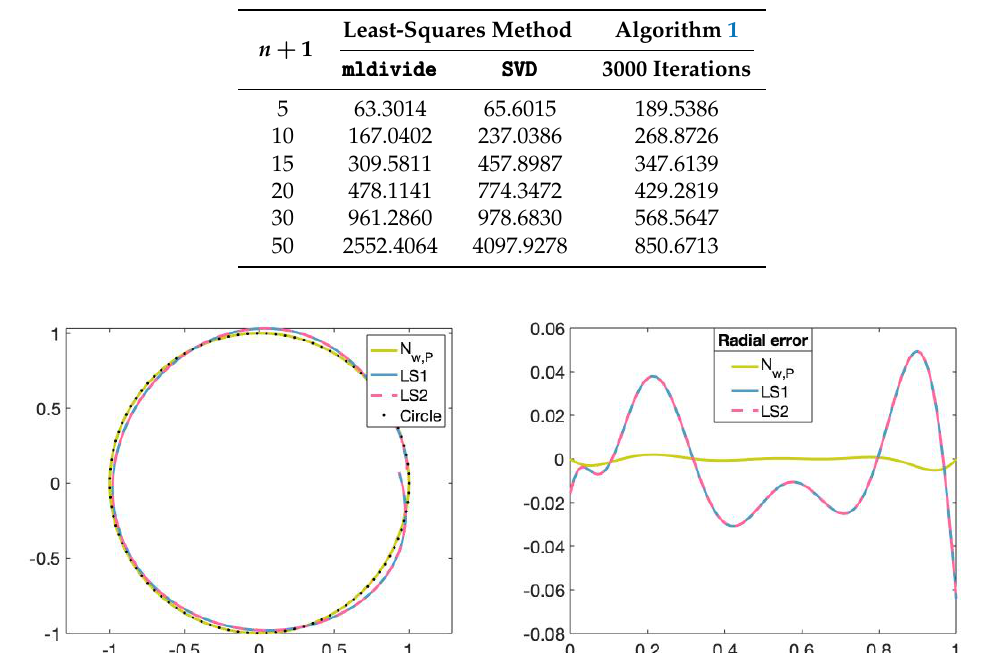
Table 3. For different number of weights and control points, the time of execution of the least-squares method using the Matlab commands mldivide and SVD , and the time of execution of the Algorithm 1 for 3000 iterations are provided. The values have been measured in seconds with a set of data points of size 100 and they are the mean of 5 repetitions.